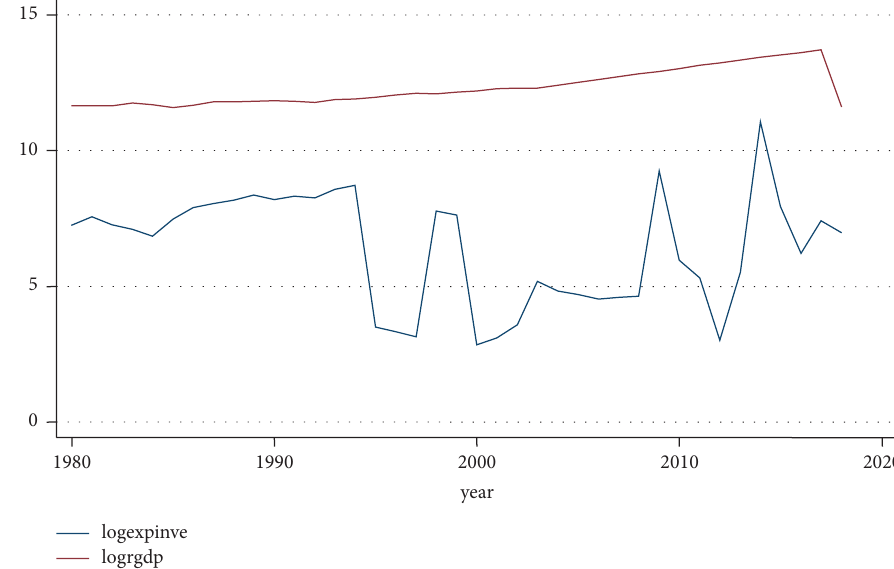
Figure 6: Expenditure on investment. Source: own computation based on the data from MOFED and National Bank, 2022.